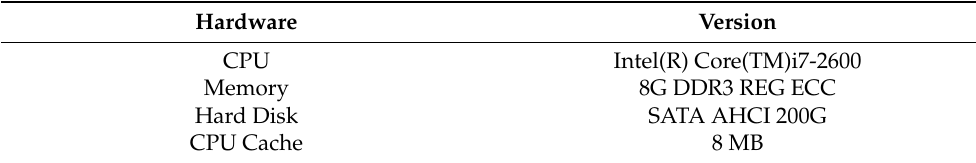
Table 7. Hardware